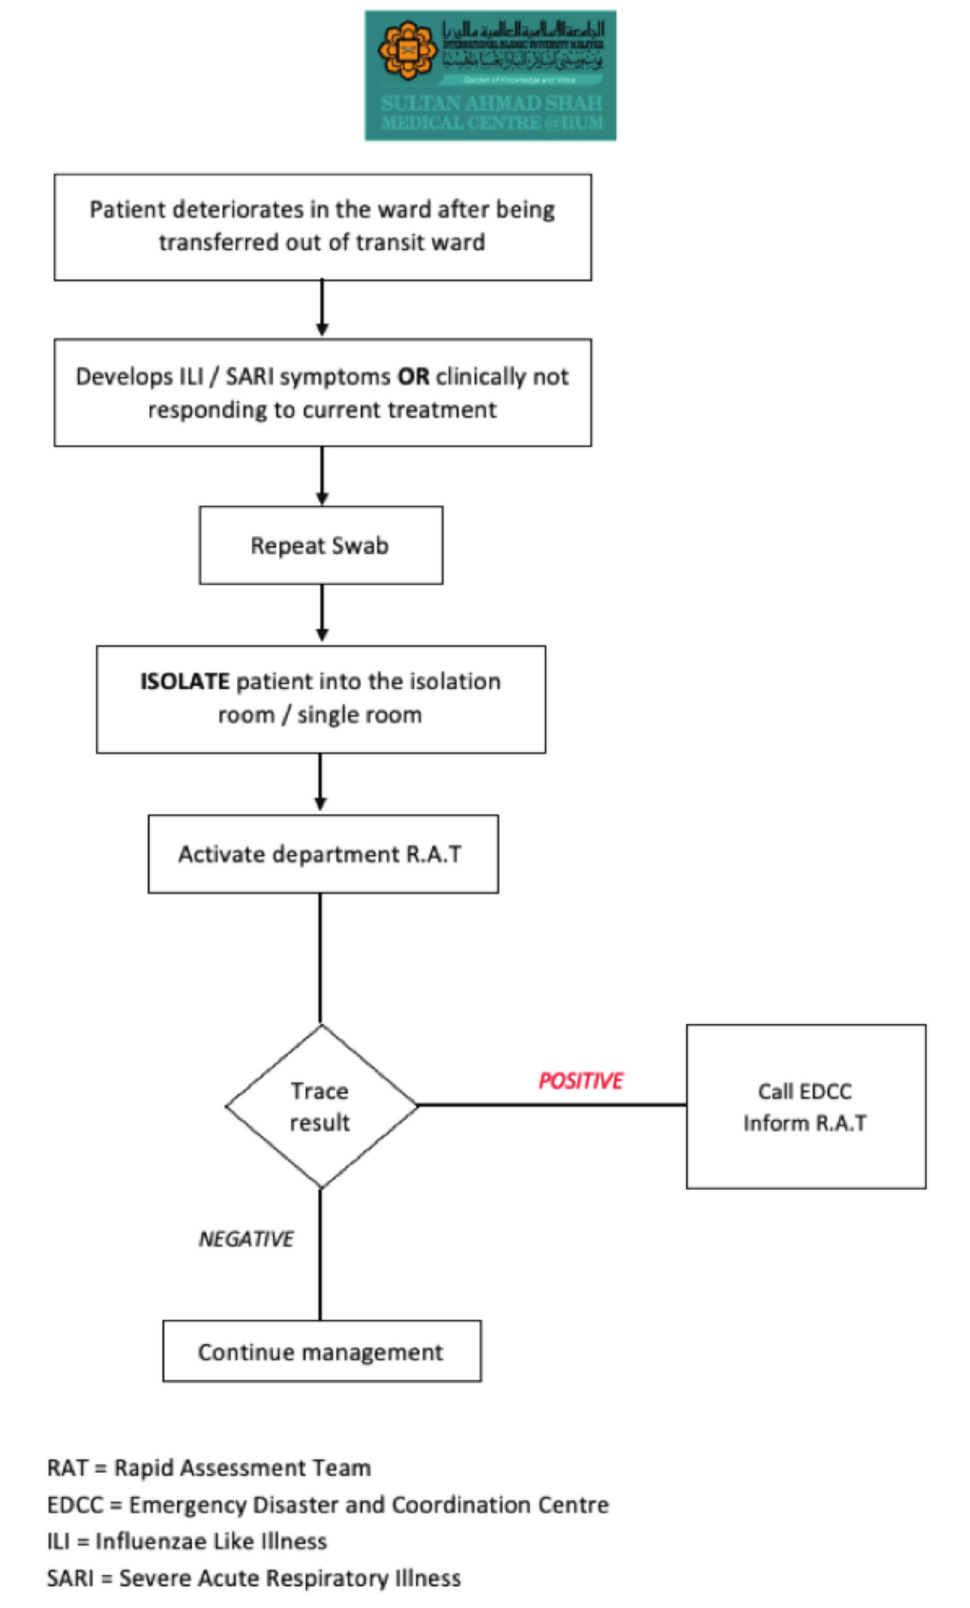
Flowchart for the management of deteriorating patients in the general ward at Sultan Ahmad Shah Medical Centre Fig. 6: